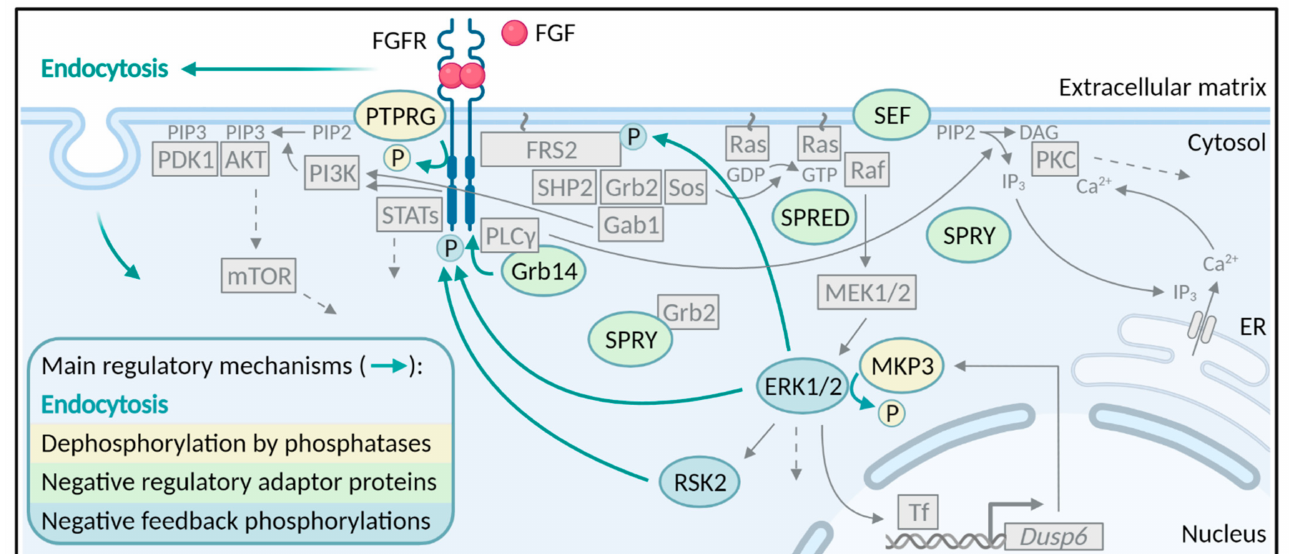
Figure 1. Turning off FGFR signaling. Endocytosis, dephosphorylation by phosphatases, inhibitory adaptor proteins competing for target and negative feedback phosphorylation loops are all mechanisms that act to turn off FGFR signaling. The four main FGFR signaling pathways, Ras-MAPK, PI3K-AKT, PLC γ -PKC and STAT pathway are indicated in gray. Green arrows indicate a negative regulatory mechanism. Tf, transcription factor, ER, endoplasmic reticulum. Created with BioRender.com, accessed on 1 May